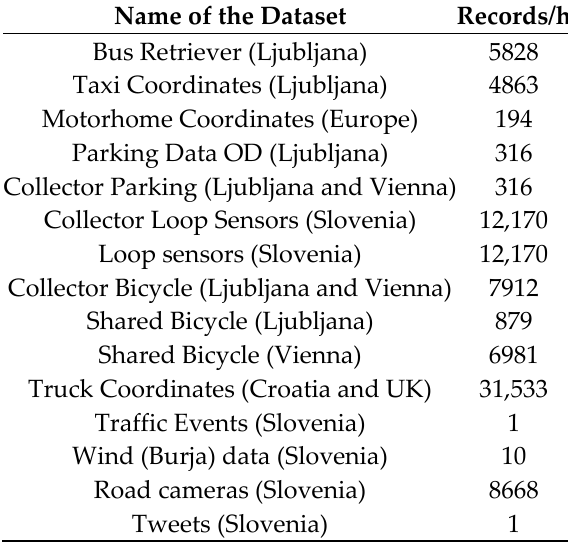
Table 1. The frequency of records per hour for a single retriever script.